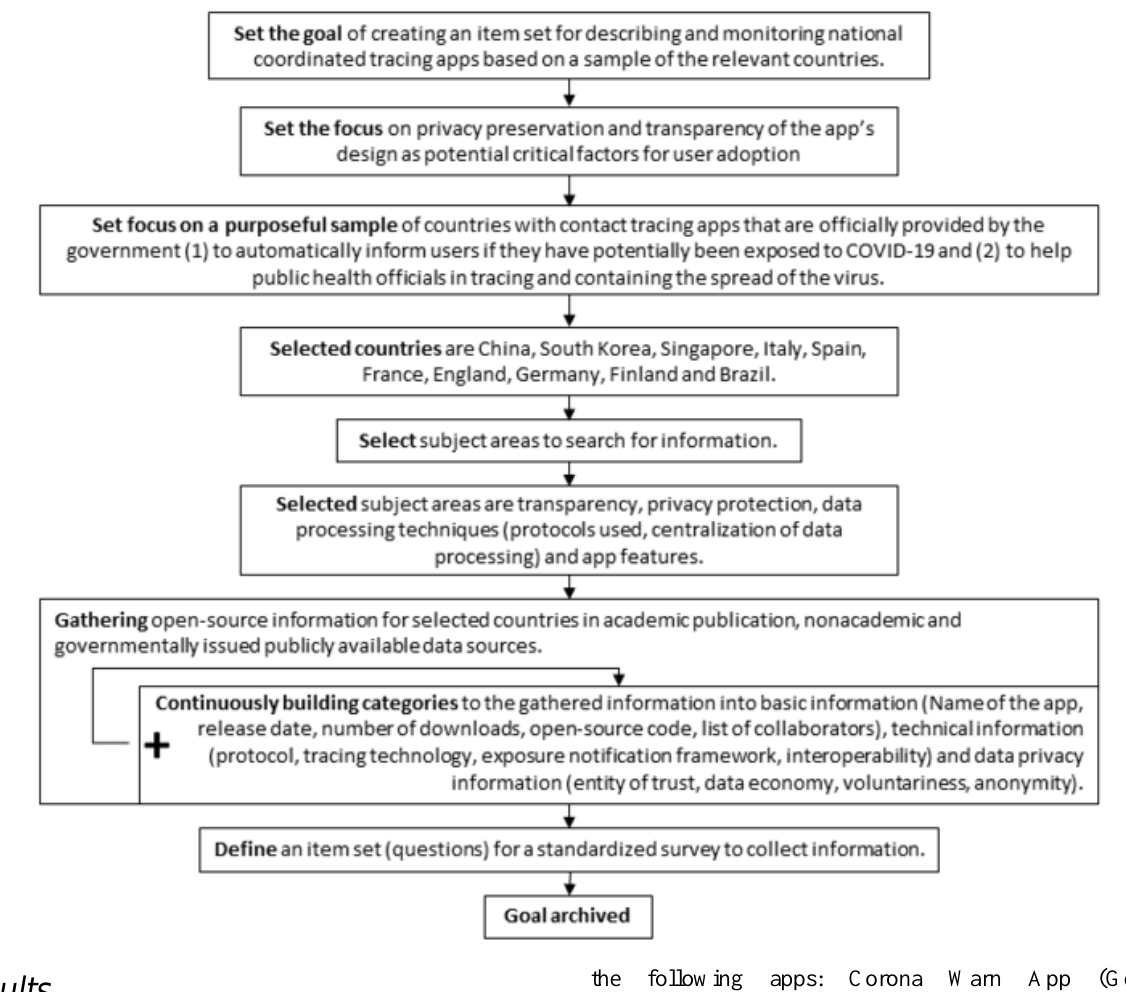
Figure 1. Sequence of methodological